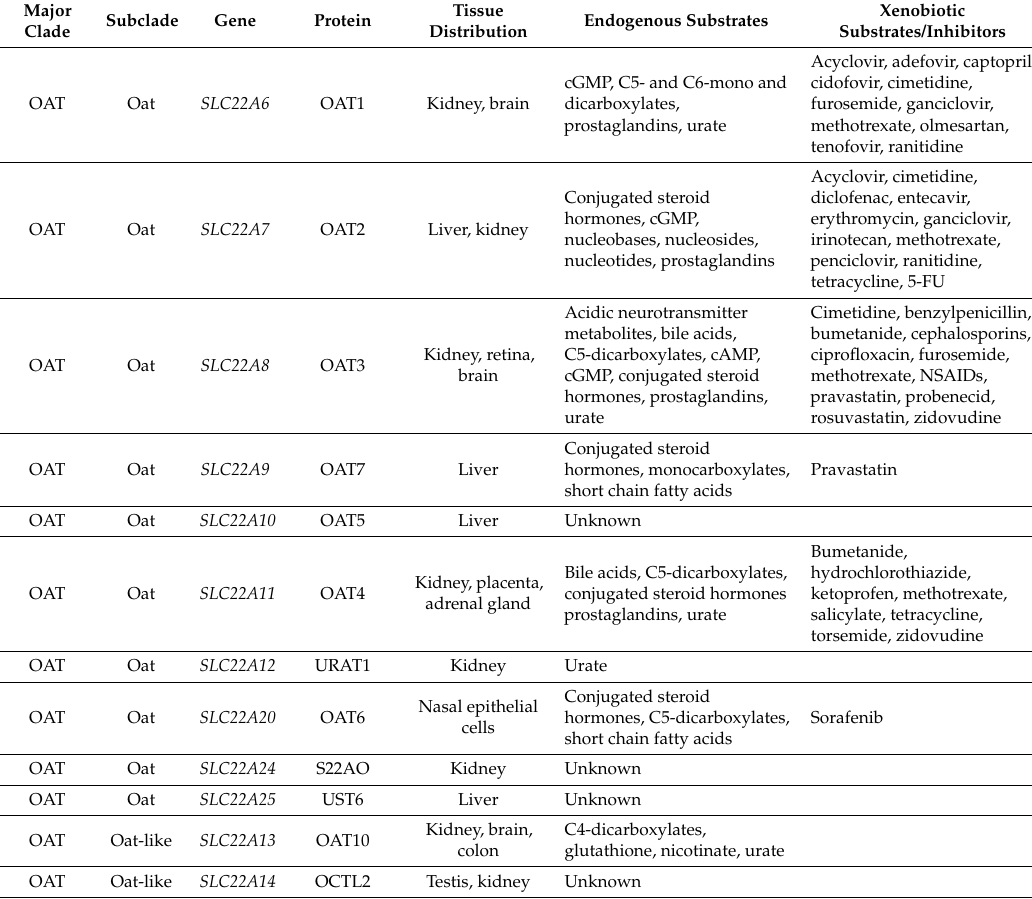
Table 2. Characteristics of the human organic anion transporters of the SLC22A